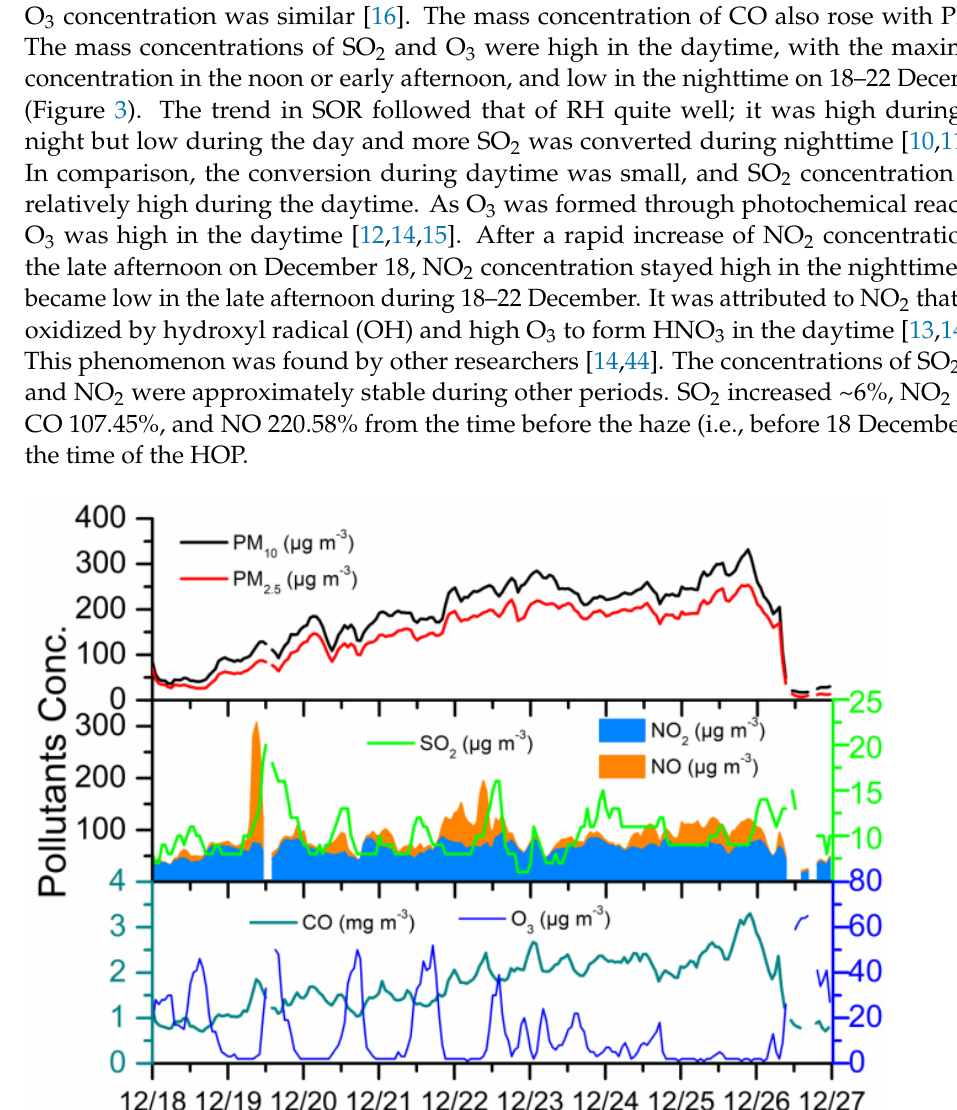
Figure 3. Evolution of particulate matter (PM 10 and PM 2.5 ) and gaseous pollutants (NO, NO 2 , SO 2 , CO, and O 3 ) from December 18 to 26.